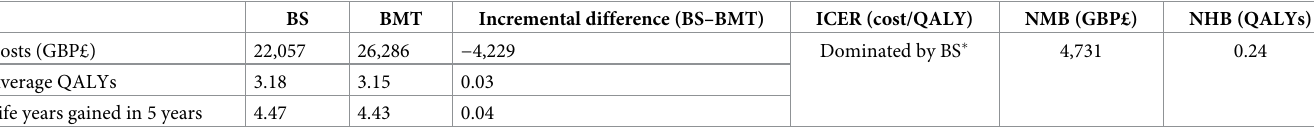
Table 10. Cost-effectiveness of bariatric surgery and